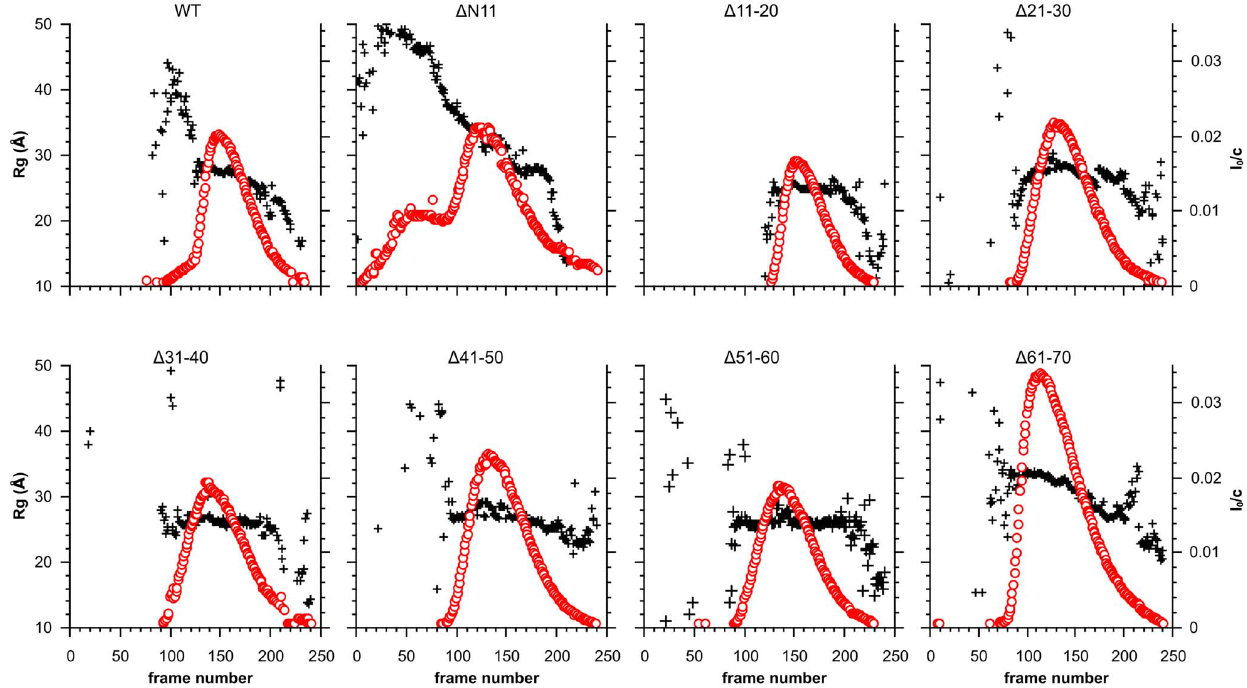
Figure 5. SAXS analysis of the HSPB6 10-residue deletion mutants. For each construct, 250 frames were collected during elution from a Shodex KW-404F column. The radius of gyration (R g ) and forward scattering (I 0 ) were calculated at each measured point using buffer subtracted scattering curves that had been averaged by a ten-frame moving average algorithm to improve the signal-to-noise. The forward scattering values are normalized by dividing the values by the concentration of the sample at the peak maximum. The R g is plotted as a black cross for each construct and scaled on the left axis, the I 0 is shown as a red circle and scaled on the right axis.